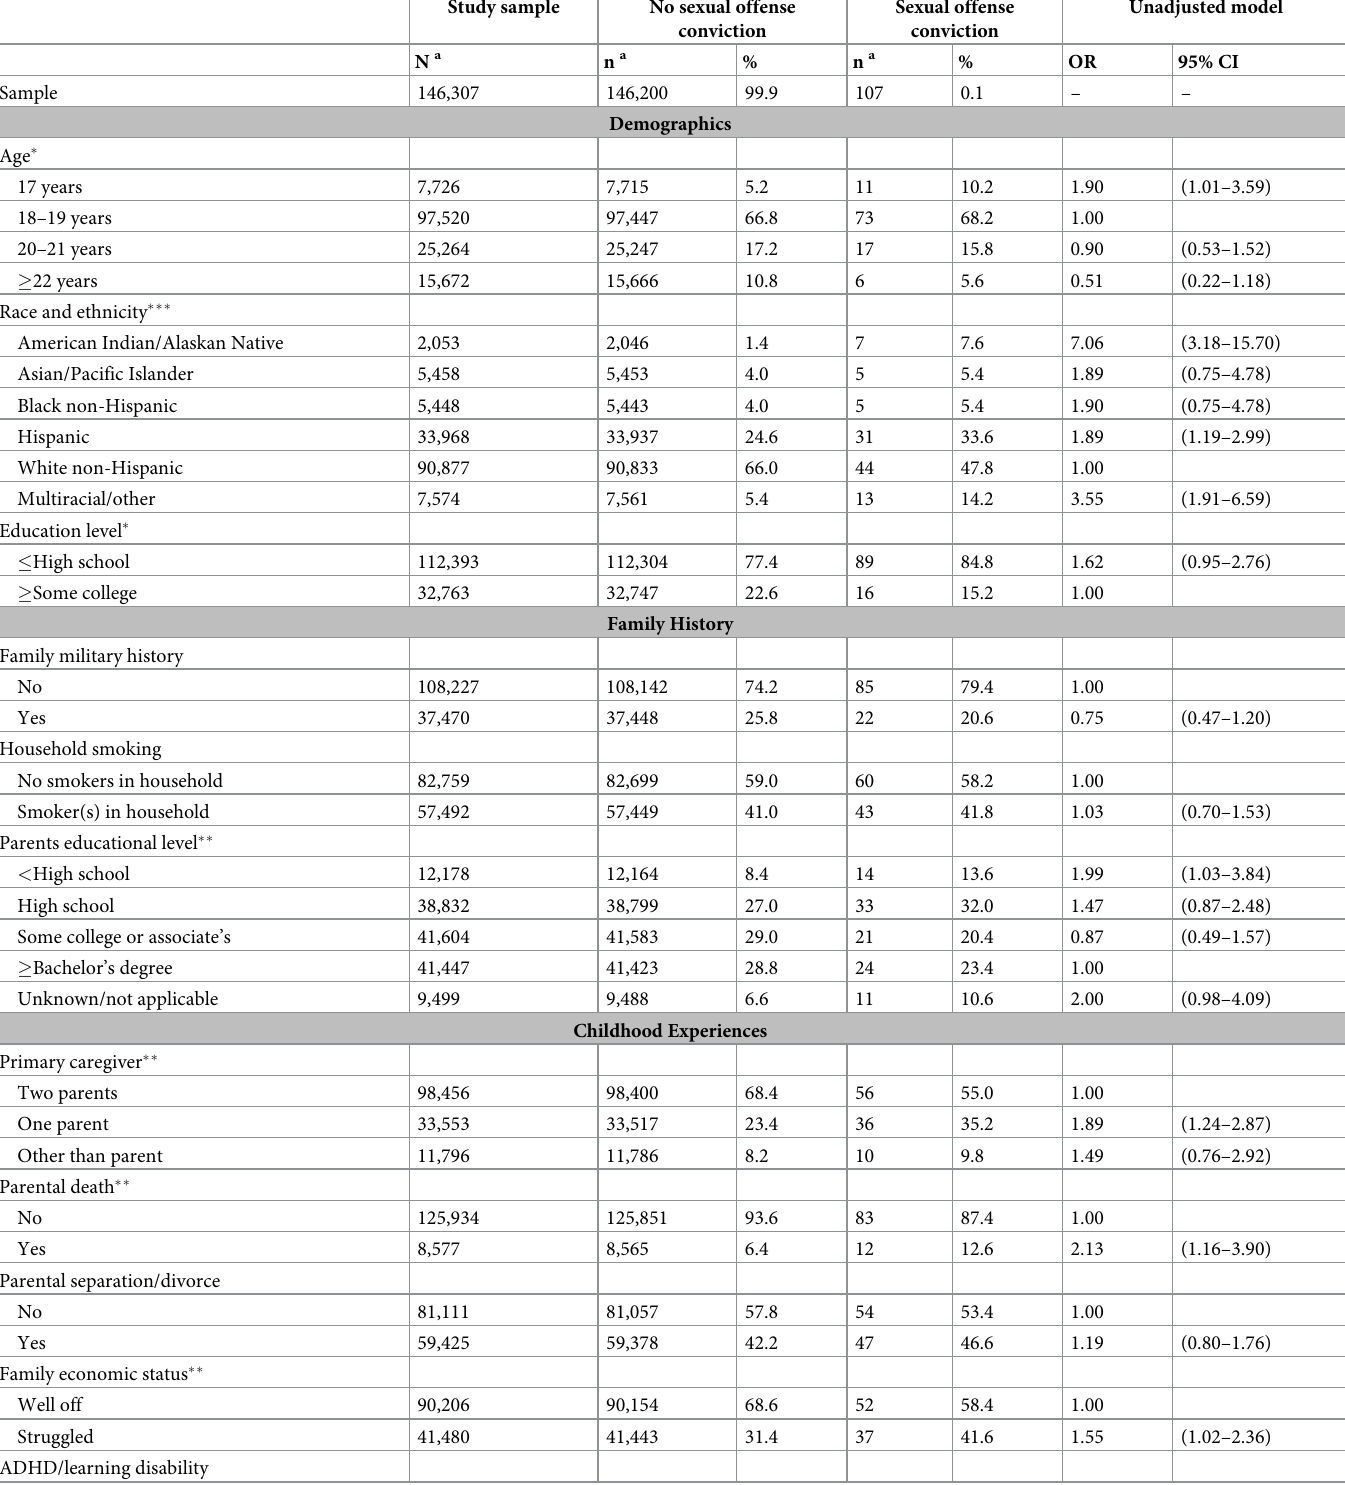
Table 1. Demographics, family history, and childhood experiences by sexual offense conviction among U.S. male